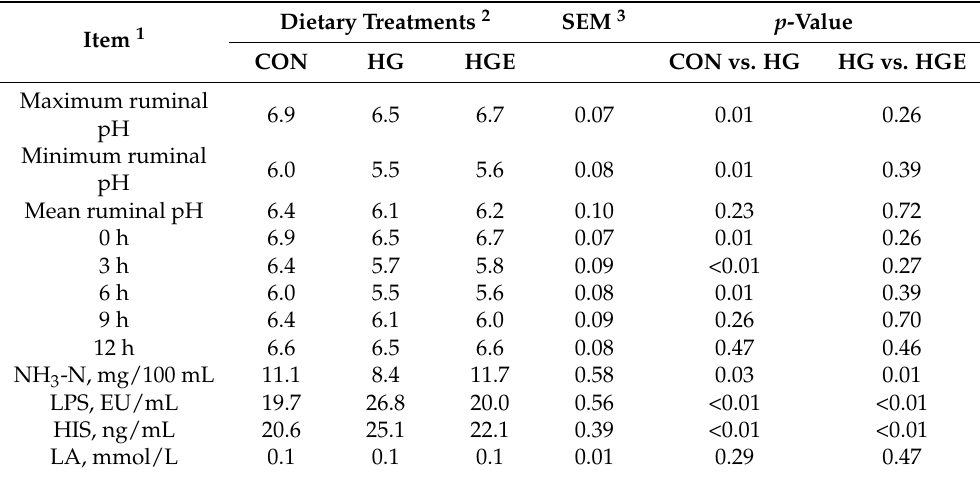
Table 4. Effects of vitamin E on rumen pH and abnormal metabolites induced by high concentration in subacute ruminal acidosis cows.